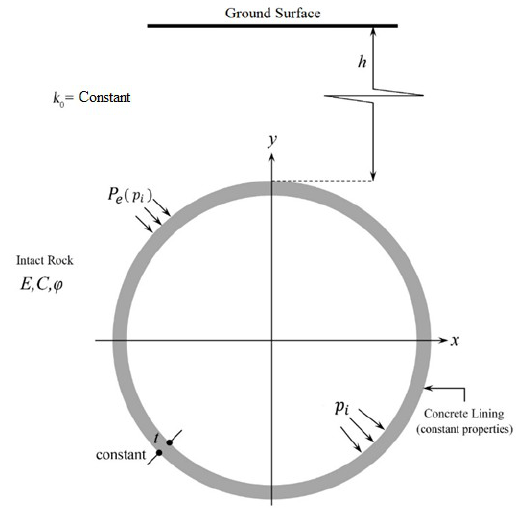
ff ective parameters in the parametric Figure 4. Effective parameters in the parametric study. Figure 4. E